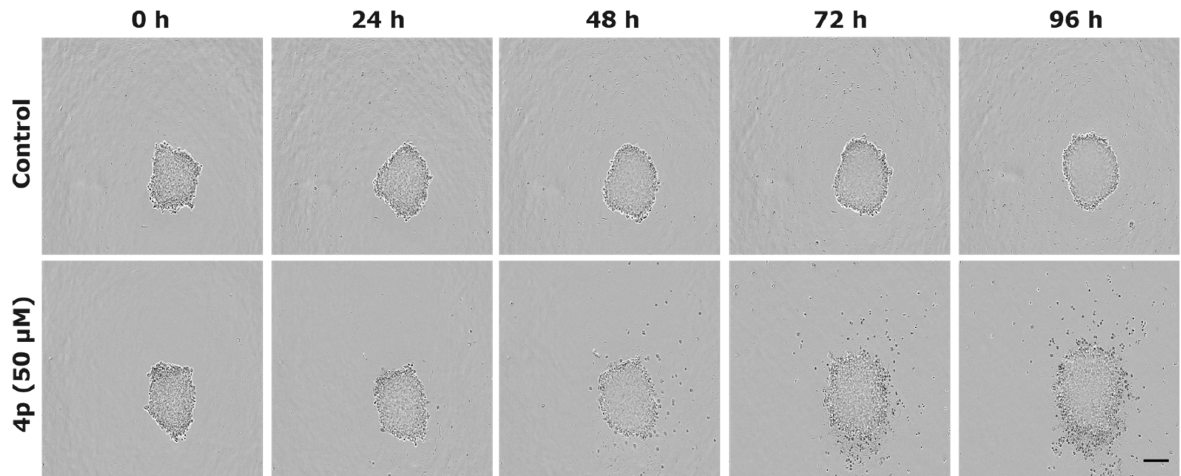
Figure 6. Effect of 4p on the integrity of multicellular spheroids from A549 cell line. Representative phase-contrast images from time-lapse imaging of spheroids treated with either 50 µM of 4p or vehicle control (0.5% DMSO). Increasing numbers of detached cells from the spheroid core start to appear at 48 h post-treatment with 4p . The figure is representative of three independent experiments, each performed at least in duplicates. Scale bar (200 µM) for all images is shown in black.